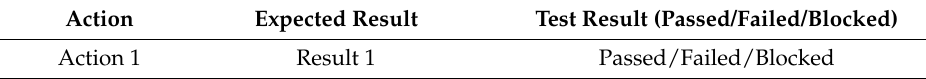
Table 1. Testing